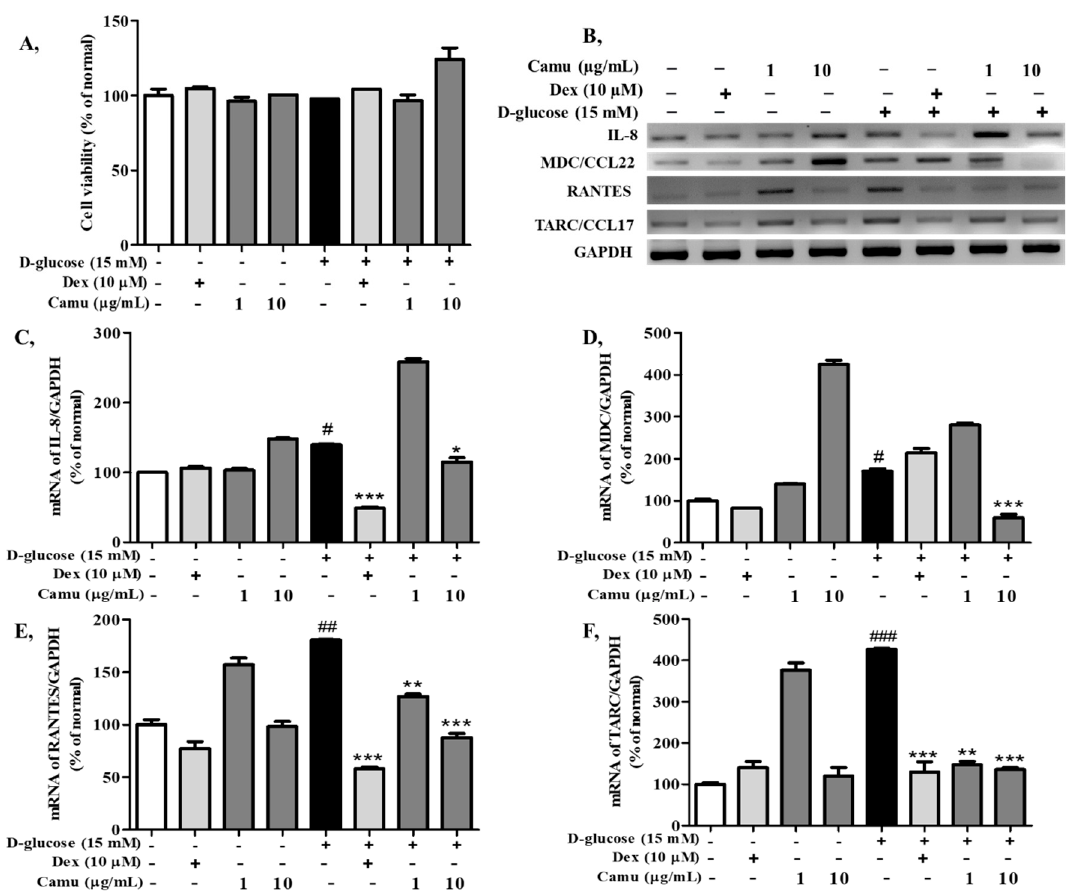
Figure 3. Effect of the camu-camu fruit extract on cell viability and mRNA expression of proinflammatory cytokines and chemokines in high glucose-induced HaCaT cells. Effect of the camu-camu fruit on the cell viability of high glucose- induced HaCaT cells ( A ). Expression of mRNA of IL-8, MDC, RANTES, and TARC in HaCaT cells under a high glucose- treated condition was measured by RT-PCR analysis ( B ). Band intensities of IL-8 ( C ), MDC ( D ), RANTES ( E ), and TARC ( F ) were calculated by densitometry and compared to GAPDH. The data are shown as the means ± SD of three independent experiments. # Significant differences between the untreated group and the high glucose ‐ induced group (# p < 0.05; ## p < 0.01; ### p < 0.001). * Significant differences between the high glucose ‐ induced group and the other groups (* p < 0.05; ** p < 0.01; *** p < 0.001).